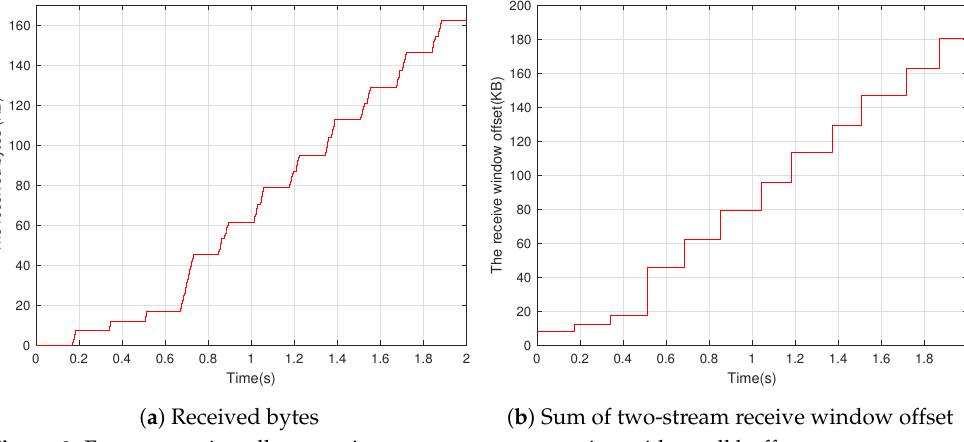
Figure 9. Fast autotuning allowance in a two-stream connection with small buffer.